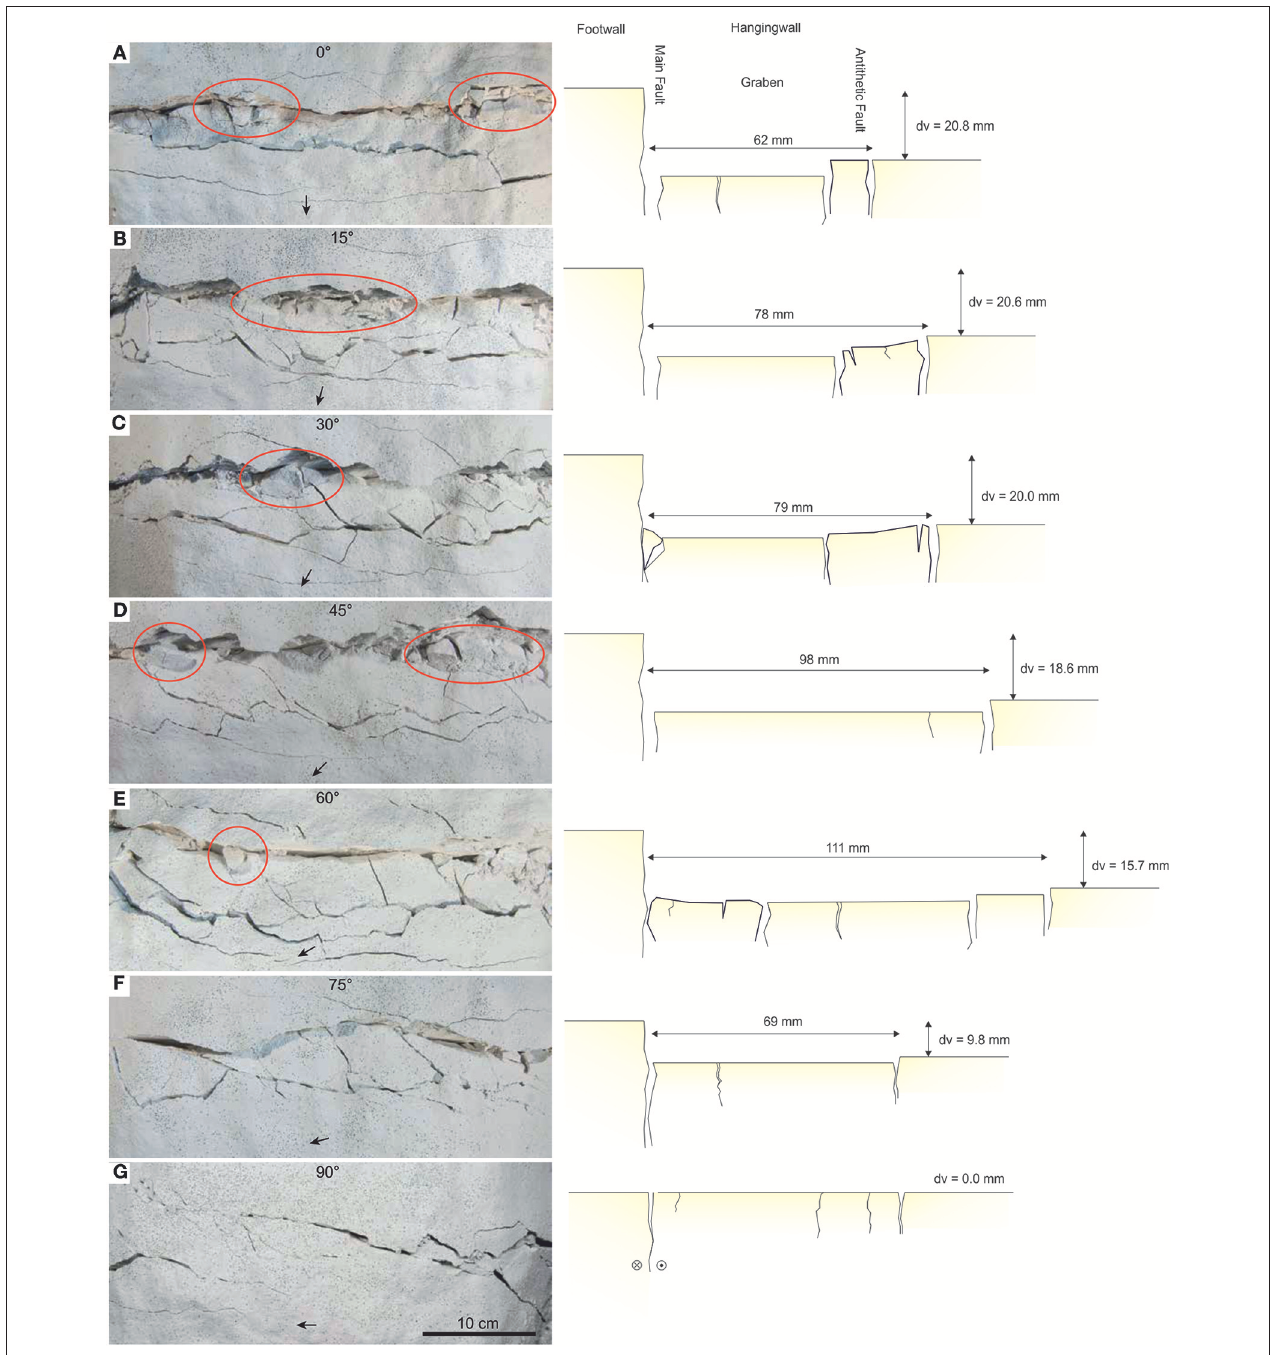
FIGURE 5 | Top view of final stages of 20 cm powder experiments and schematic cross section perpendicular to basement fault strike. (A–G) Obliquity increases from 0 to 90 ◦ . Same experiments as shown in Figure 4 . Pictures were taken after 24mm of deformation. This is a stage where the fault has reached a mature phase, i.e., further extension is almost exclusively accommodated by widening of pre-existing fractures. At obliquities between 0 and 60 ◦ a graben forms between the main fault and the antithetic fault on the hangingwall. At low obliquities, the entire fault shows dilatancy, whereas at higher obliquities dilatancy is restricted to releasing bends. Note how final fault geometries are influenced by orientation of early fractures ( Figure 4 ). Red circles denote tilted blocks. Cross sections show vertical throw associated with fault movement (dv), and average widths of grabens.